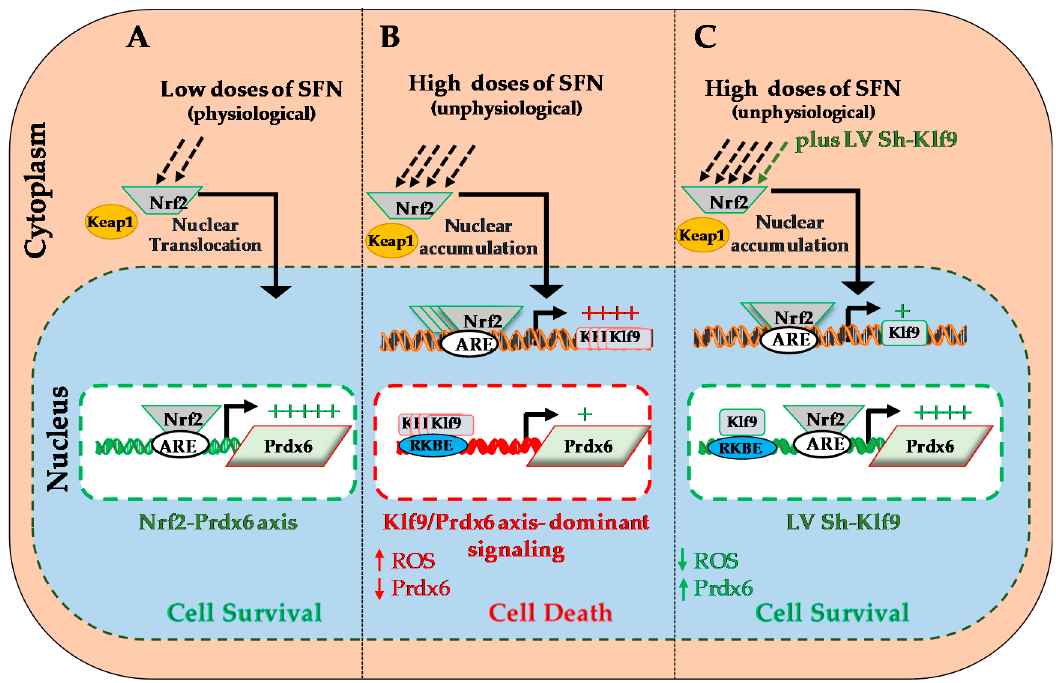
Figure 9. Diagram illustrating a plausible molecular mechanism underlying the SFN evoked Nrf2 / Klf9 / Prdx6 axis that determines cell fate. Role of Nrf2 / Klf9 / Prdx6 axis in response to SFN. ( A ) At physiological level Nrf2-Keap1 complex resides in cytoplasm. With nonlethal doses of SFN (electrophilic stress), Nrf2 translocalizes into nucleus, binds to ARE in regulatory region of antioxidant genes like Prdx6 gene promoter, and upregulates their transcription to maintain redox homeostasis and defend cells from stressors. ( B ) At high (lethal) doses of SFN, excess Nrf2 accumulates in the nucleus and induces expression of transcription factor Klf9 via ARE site(s) present in its promoter. Klf9 represses Prdx6 expression by binding to repressive binding element(s) (RKBE) in the Prdx6 gene promoter, resulting in increased ROS-mediated cell death. ( C ) Klf9 can be depleted by use of its Sh-Klf9, eliminating the adverse signaling caused by lethal doses of SFN. This suggests that Klf9 upregulation is an important molecular mechanism underlying SFN-induced ROS-mediated cell